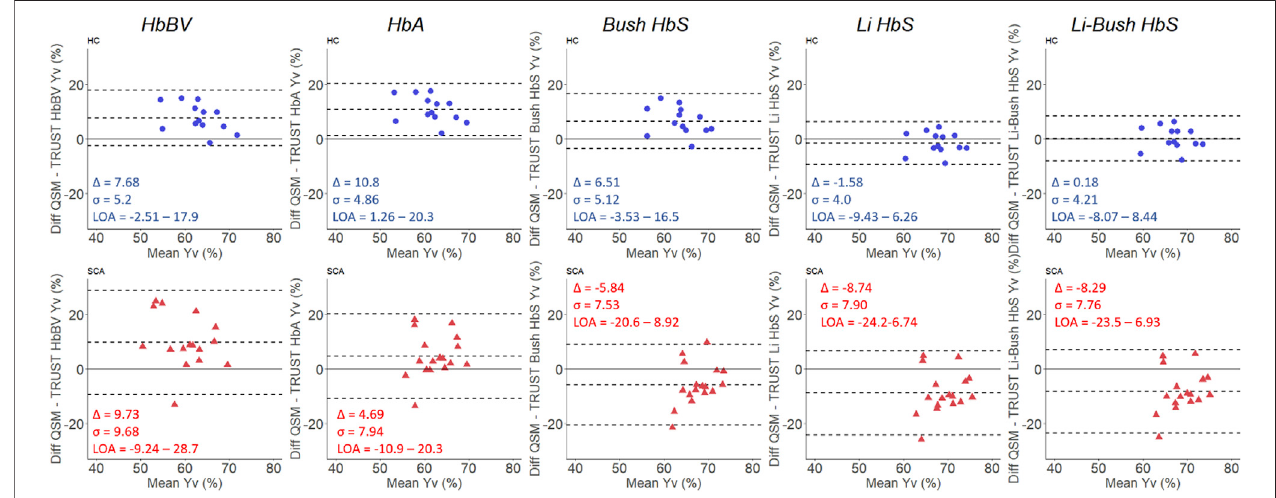
FIGURE4| Bland-Altman plotscomparingQSM and TRUST-based measures ofvenousoxygen saturation (Y v ) inhealthycontrol (blue: top) and sickle cell anemia (red: bottom) subjects. The mean bias ( Δ ) standard deviation of the bias ( σ ) and the limits of agreement (LOA) are shown for each plot.